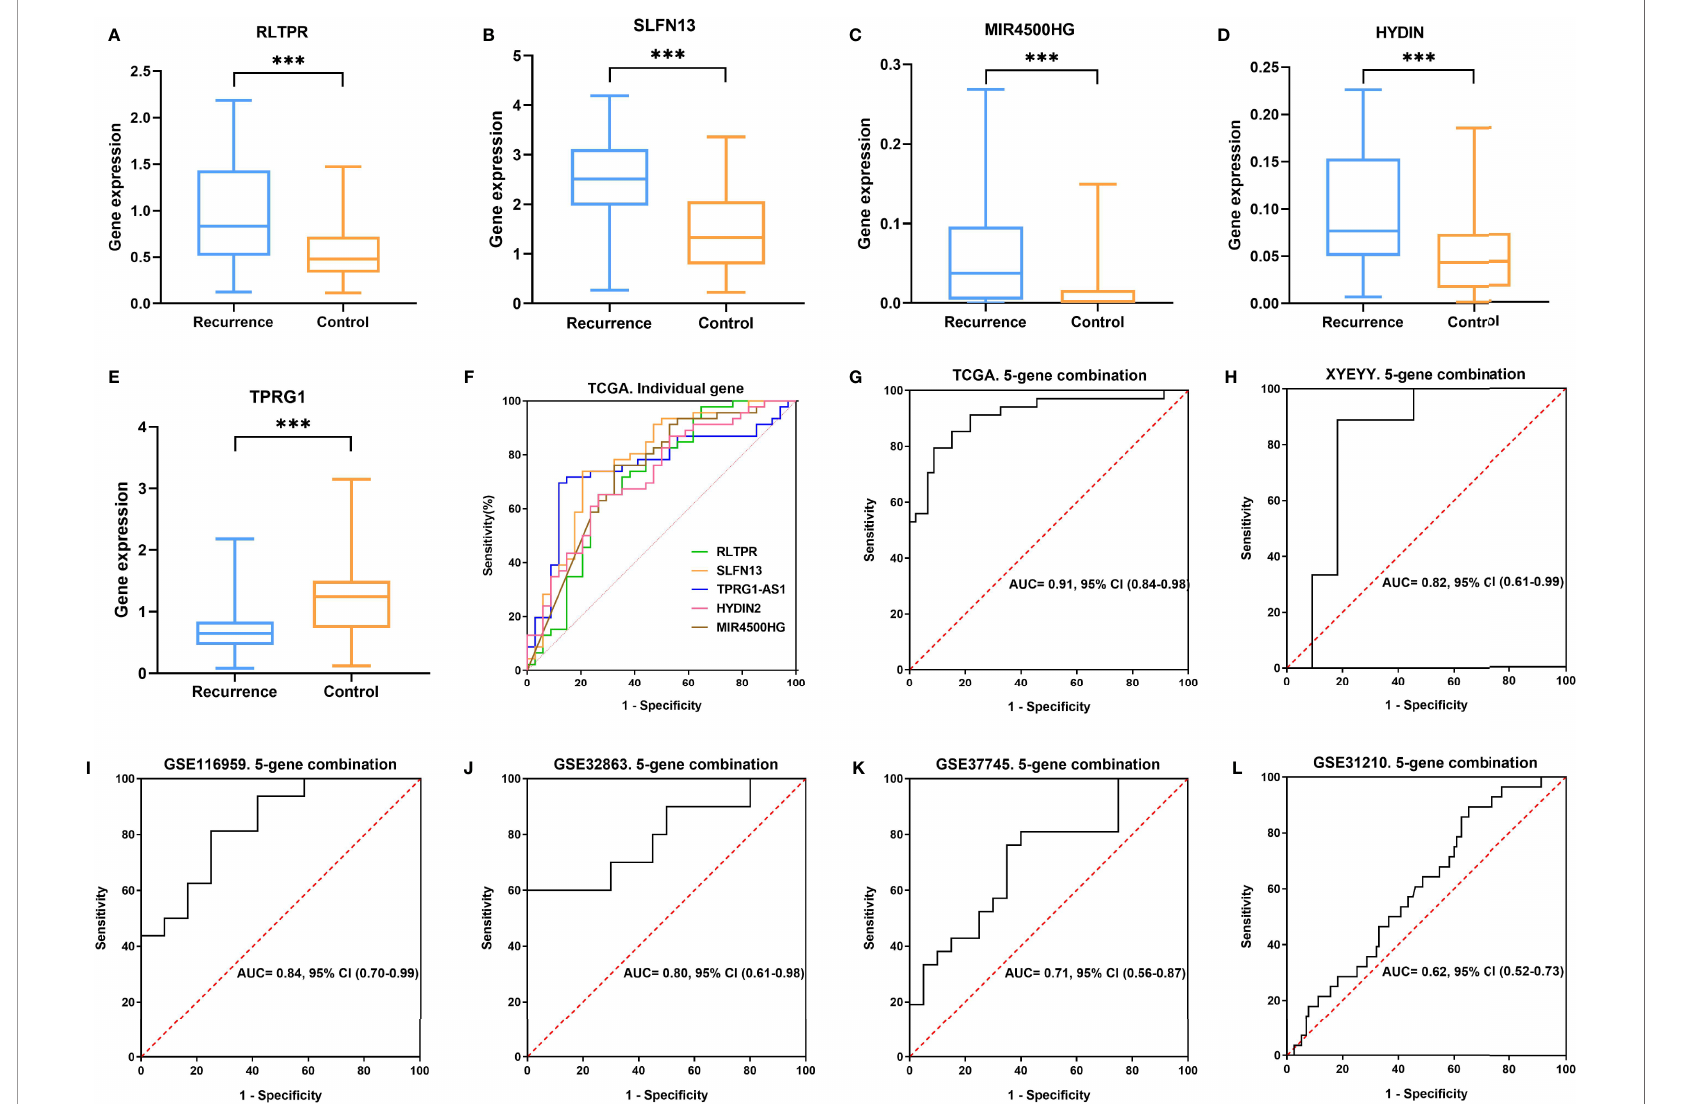
FIGURE 4 | (A – E) In the TCGA cohort, the expression of RLTPR, SLFN13, HYDIN and MIR4500HG was higher in the recurrence group than in controls TPRG1 were signi fi cantly down-regulated in the recurrence group (***p < 0.001). (F , G) ROC curves for lung cancer early recurrence prediction using single gene and fi ve-gene combination in TCGA cohort. (H – L) ROC curves for lung cancer early recurrence prediction using fi ve-gene combination in XYEYY cohort and GEO